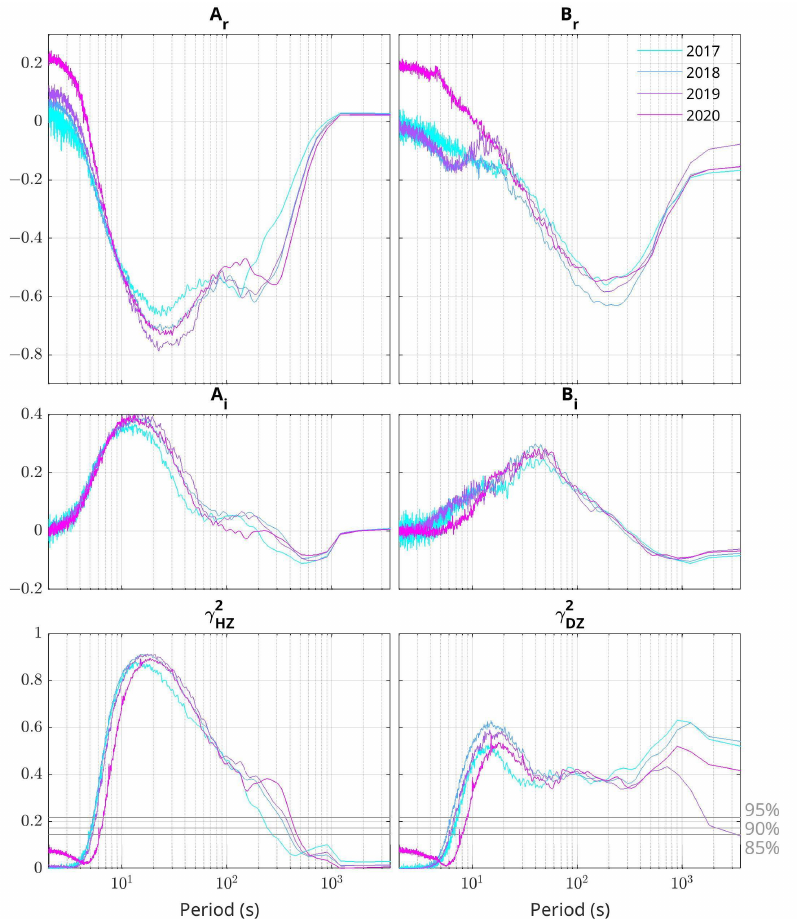
Figure 3. Transfer functions at DUR for the pairs HZ ( left ) and DZ ( right ) in both real ( r ) and imaginary ( i ) parts. Bottom panels report the ordinary (univariate) coherences between vertical and horizontal components. In the bottom panels, the coherence thresholds at 85, 90 and 95%, estimated by a Monte Carlo method, are shown as horizontal gray